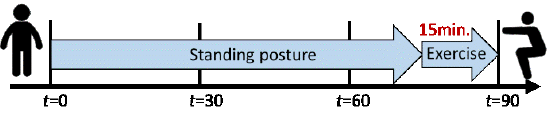
Fig. 3. Schematic diagram of the experimental schedule. After the 3 rd measurement ( t = 75 min), the subject did exercise to promote varying water contents compared to the original physiological state at the beginning of the experiment.